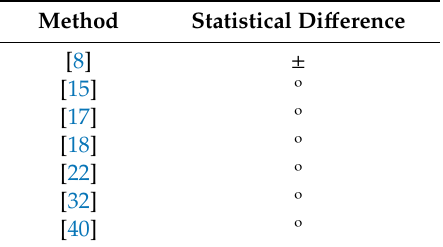
Table 16. Comparison between proposed and other methods in terms of statistical di ff erence (two-tailed unpaired student t-test, significant level